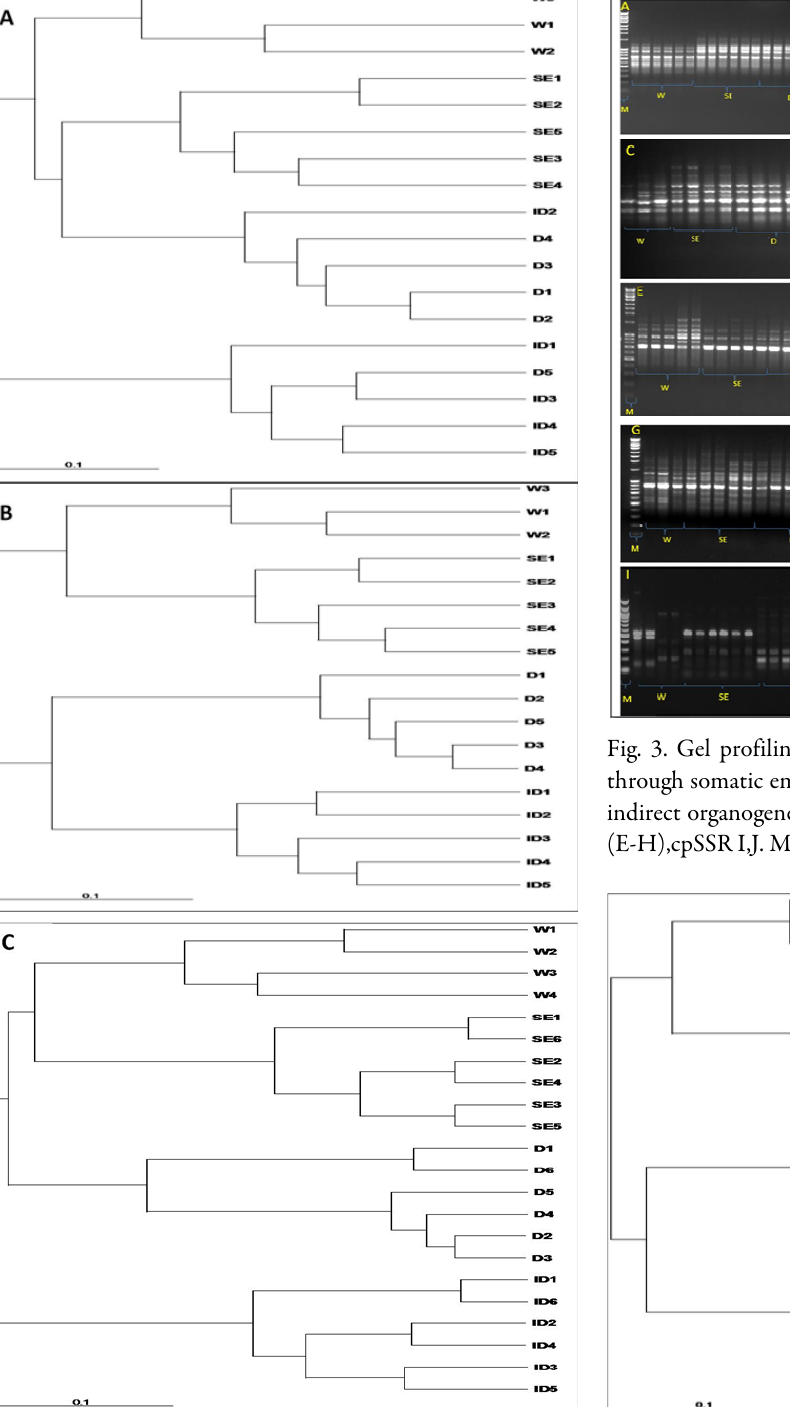
Fig. 2. Dendrogram generated using UPGMA analysis estimated by Jaccard similarity coefficient (100 bootstrap)based on different markers:(A) ISSR, (B) RAPD, (C) cpSSR, for wild plants (W) and in vitro regenerated plants from somatic embryogenesis (SE), direct organogenesis (D) and indirect organogenesis (ID)